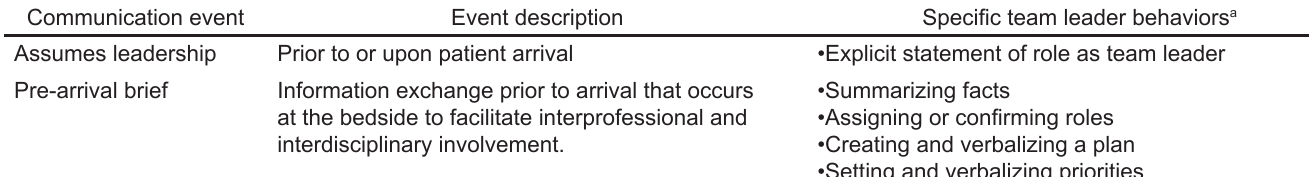
Table 1. Learning objectives for the trauma team leadership curriculum.